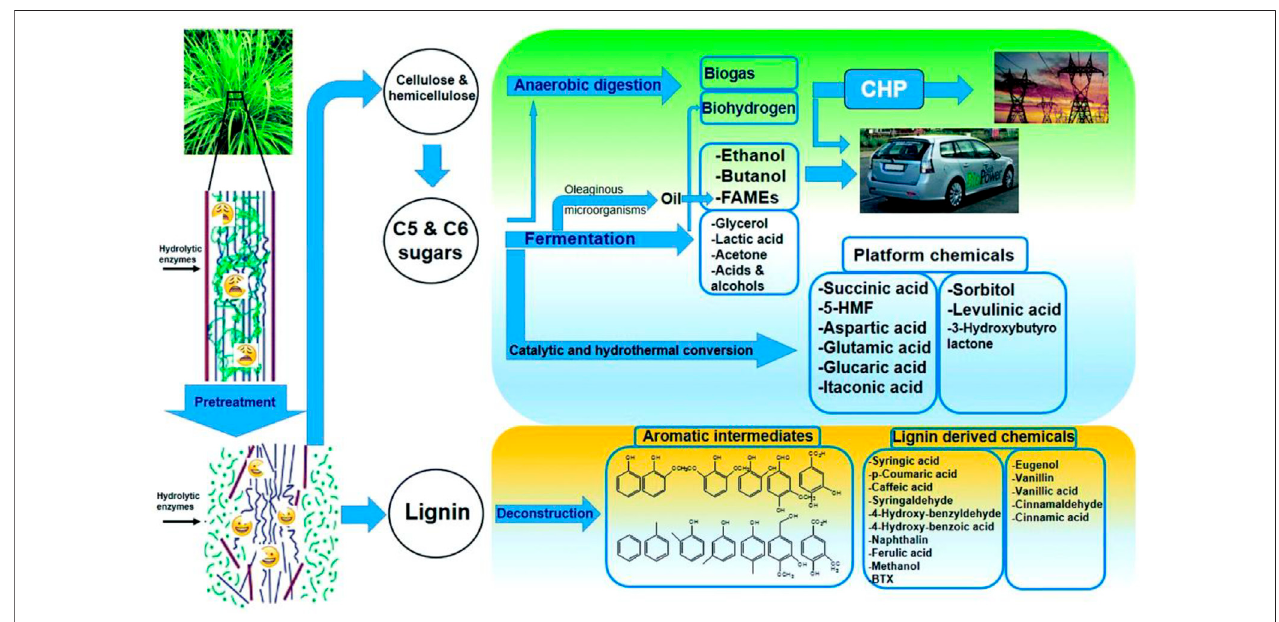
FIGURE 4 | Generation of diverse valuable chemicals and biofuels from lignocellulosic biomass. Reproduced with permission from Satari et al. (2019).